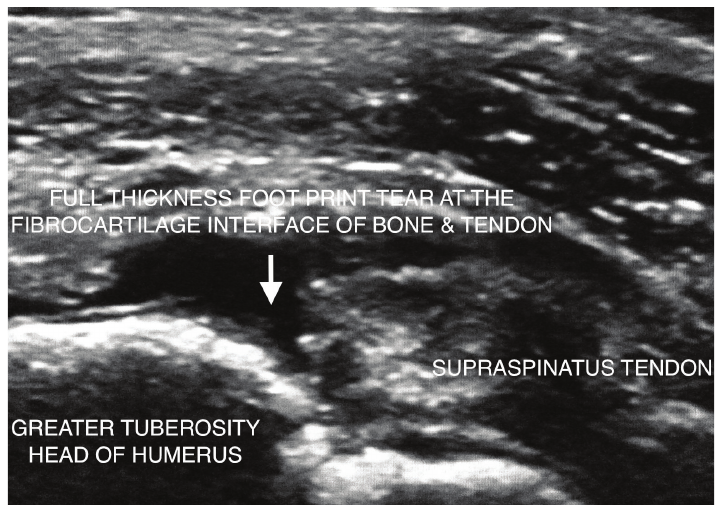
Figure 1. Long axis ultrasound image shows a full thickness footprint supraspinatus tear superimposed on degenerative tendinosis. Tear outline is well appreciated from distension of the peritendinous and subdeltoid bursal space during percutaneous treatment with tenotomy and liquid platelet rich